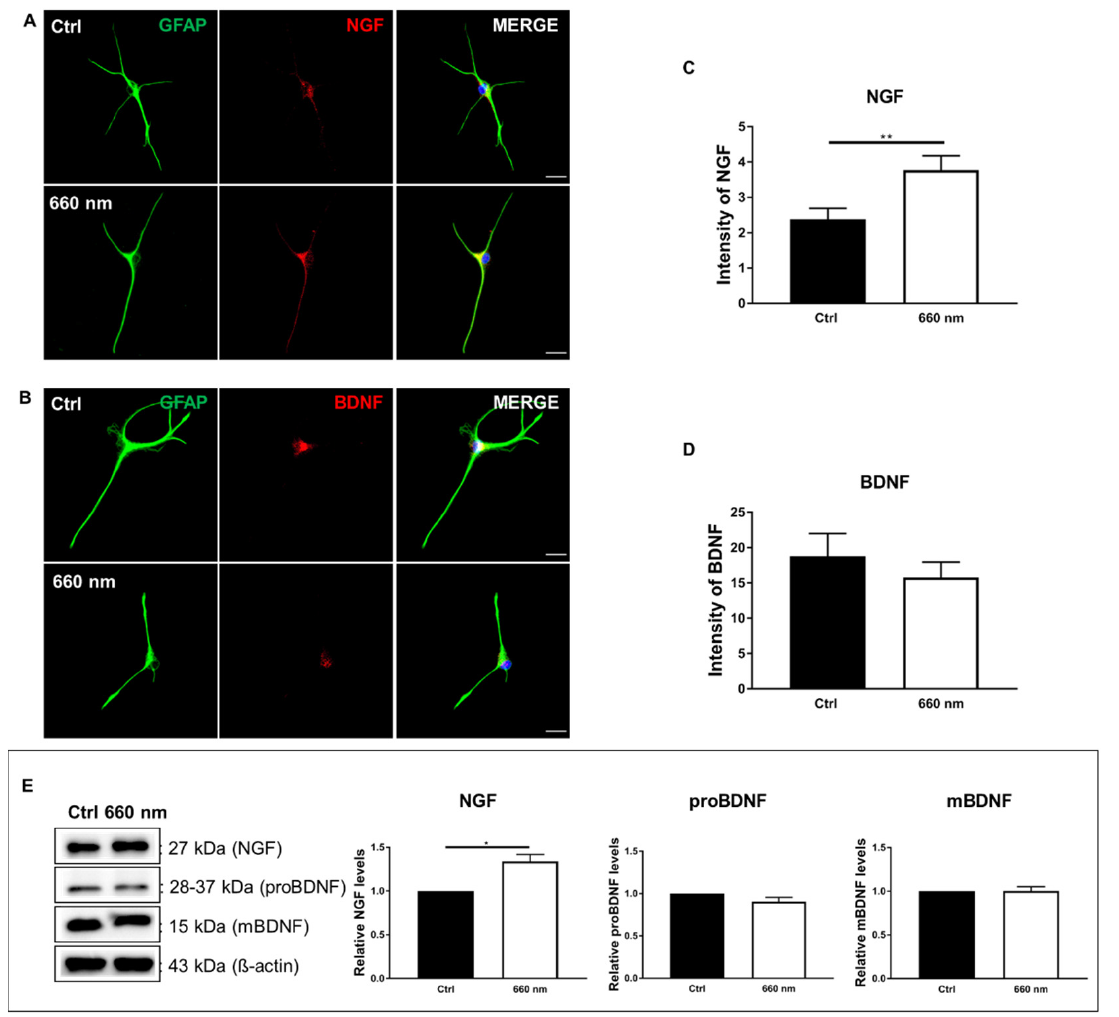
Figure 7. Alteration of NGF by 660-nanometer LED Irradiation. ( A , B ) Representative GFAP (green), NGF, and BDNF (red) immunostaining images (Scale bar: 25 µ m); ( C , D ) NGF and BDNF analyses; ( C ) The intensity of NGF was significantly increased by 660-nanometer LED irradiation compared to control cells ( n = 30, ** p < 0.01); ( D ) BDNF expression was decreased by 660-nanometer LED irradiation, but not significantly; ( E ) Western blot analysis of neurotrophic factors. In accordance with the immunofluorescence data, the expression levels of neurotrophic factors were altered by 660-nanometer LED irradiation, especially NGF, which was significantly increased ( n = 4, * p < 0.05). Full-length blots/gels are presented in Supplementary Figure